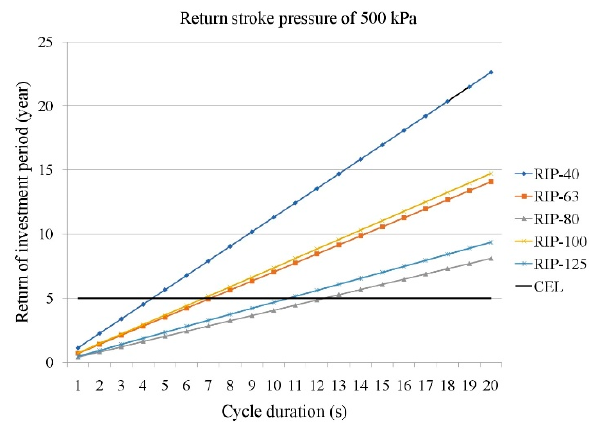
Figure 6. Return of investment period (RIP) with return stroke pressure of 500 kPa.